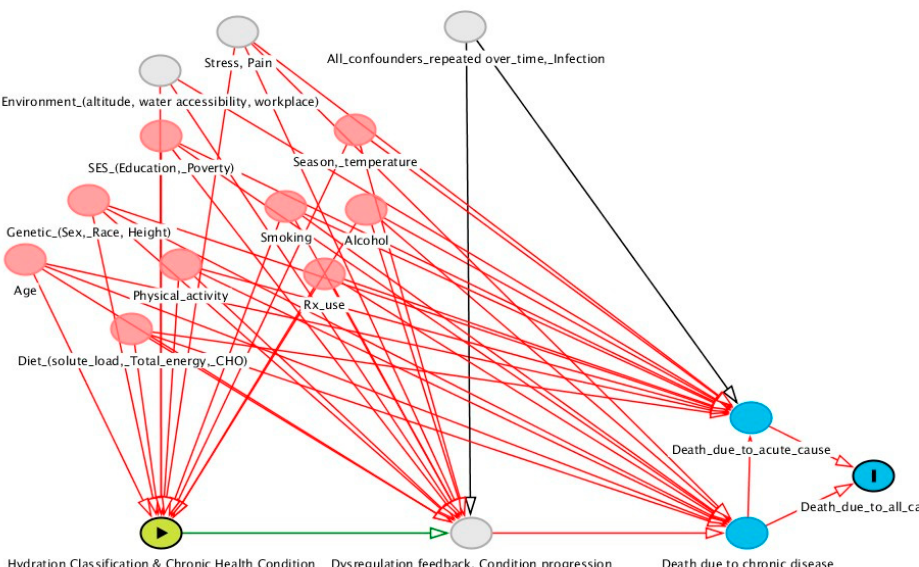
Figure 1. Directed acylic graph (DAG) representing the hypothesized joint effect of hydration classification and chronic health condition on death. The yellow circle highlights the joint exposure. The blue circles represent the outcome. The pink and grey circles represent covariates that were observed and unobserved by National Health and Nutrition Examination Survey (NHANES), respectively. The DAG assumes that the hydration classification is a function of water intake requirements, water intake, and health condition. Many unobserved covariates and interrelationships between covariates are not shown. Figure 1 was generated using DAGgity.net